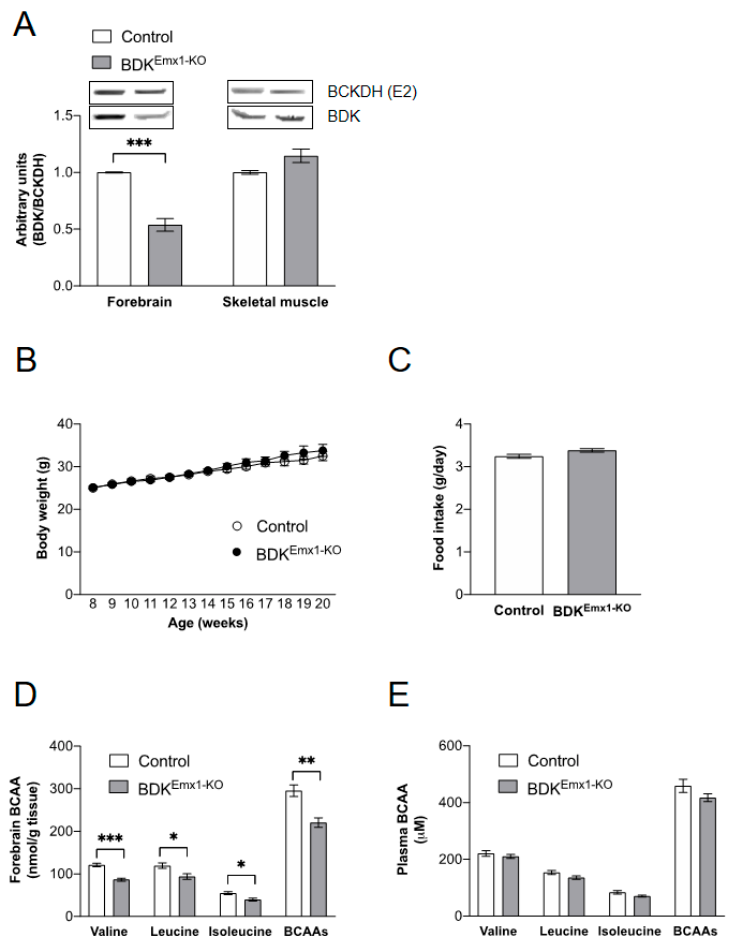
Figure 1. Characterization of BDK Emx1-KO mice. BDK protein expression in the forebrain and skeletal